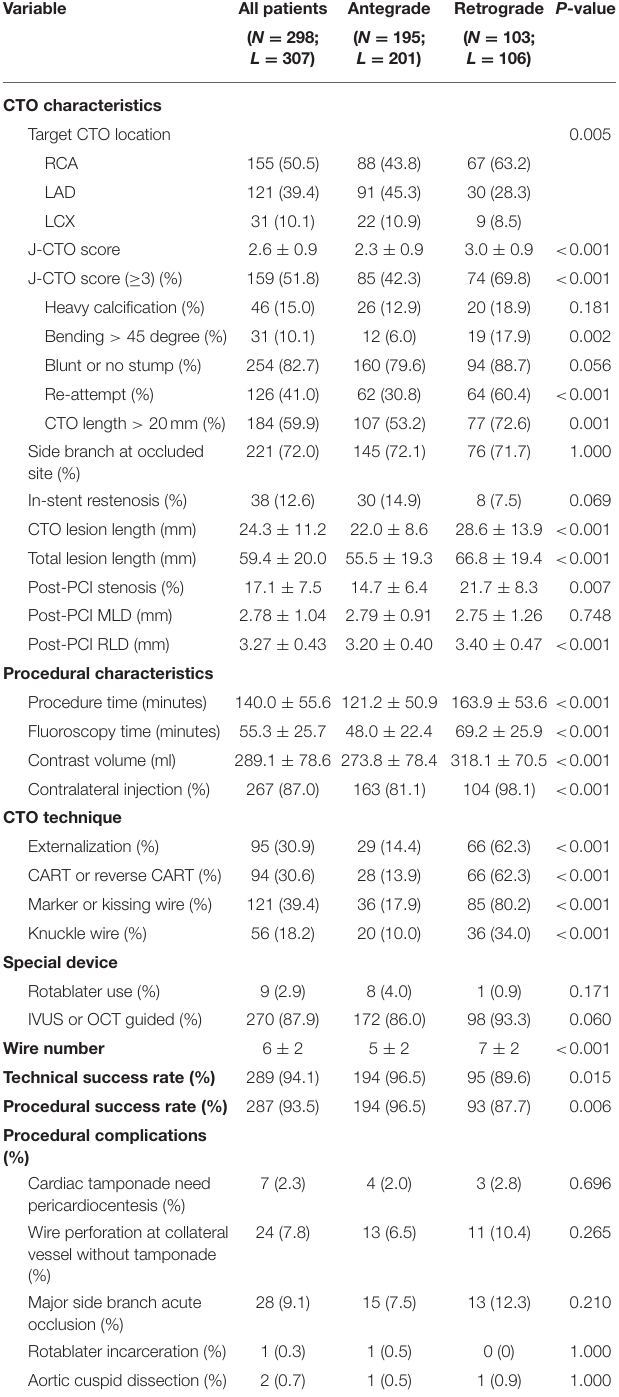
TABLE 3 | The characteristics of the CTO lesions and procedural characteristics. Variable